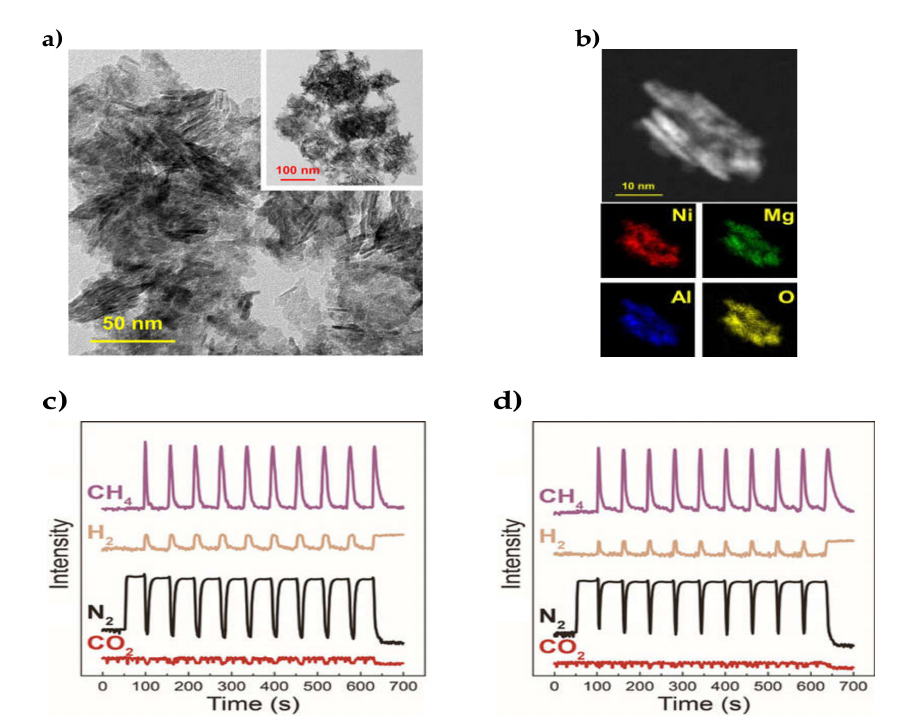
Figure 13. ( a ) TEM images and ( b ) EDX Mapping of 2.0NiMgAl-LDO. Continuous CO 2 capture and methanation over 2.0NiMgAl-LDO-re at 250 ◦ C (Adsorption: 15 vol% CO 2 / N 2 (70 mL min − 1 ), 1 bar; methanation: 100 % H 2 (70 mLmin − 1 ), 1 bar); ( c ) t adsorption = 30 s, t methanation = 30 s; and ( d ) t adsorption = 35 s, t = 25 s. Reproduced with permission from ref. [121]. Copyright 2019 methanation